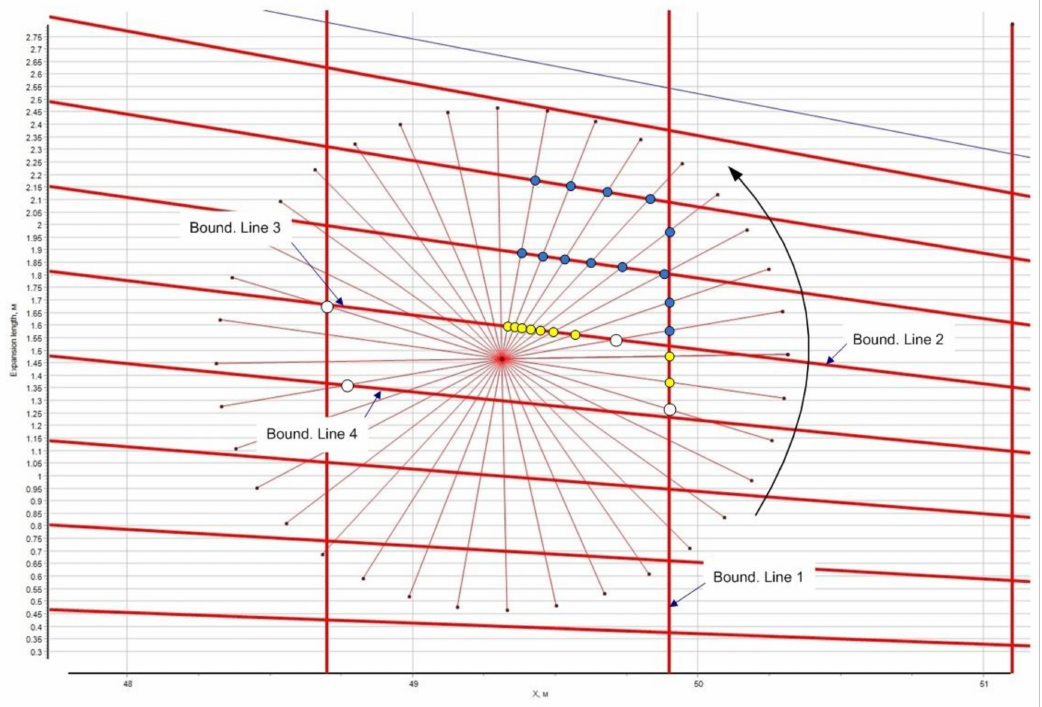
Figure 11. Primary point (in the middle), ray sections and panel